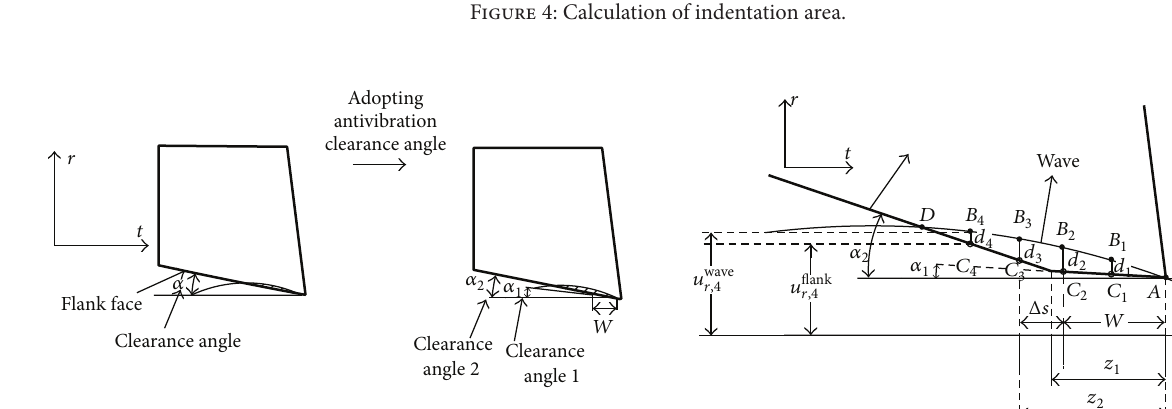
Figure 5: Effects of antivibration clearance angle on indentation area.